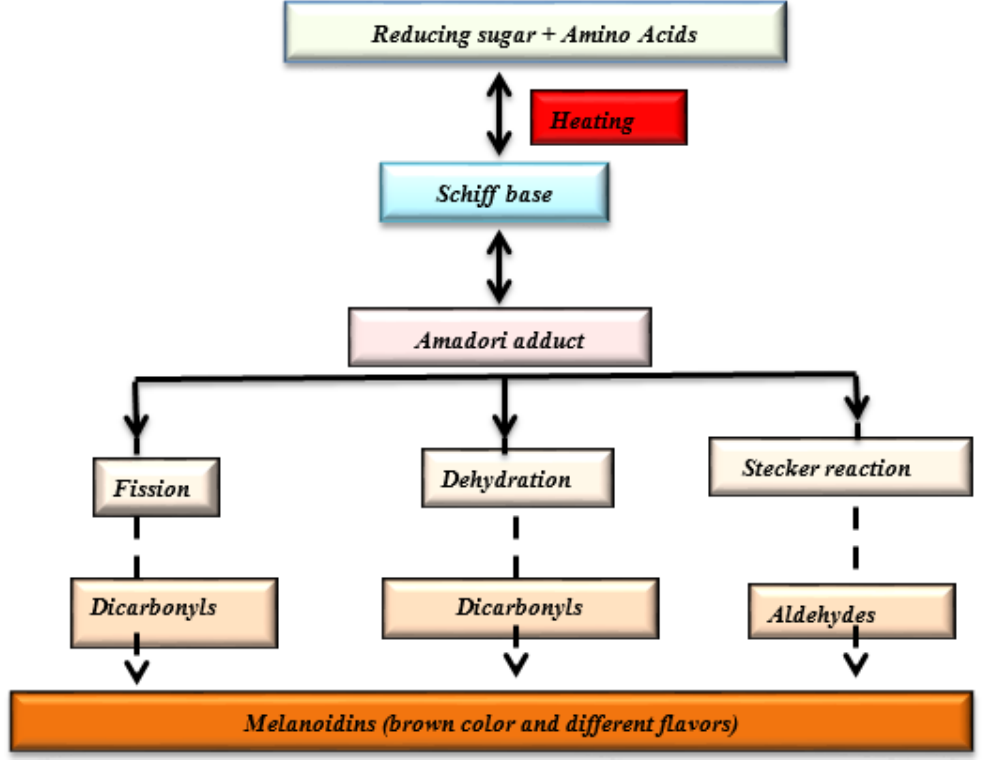
Figure 3. Schematic showing how the Maillard reaction results in color and flavor generation. The reduction of sugars and amino acids in peanuts reacting at high temperatures with low water activity during roasting generates a brown color and various flavors.